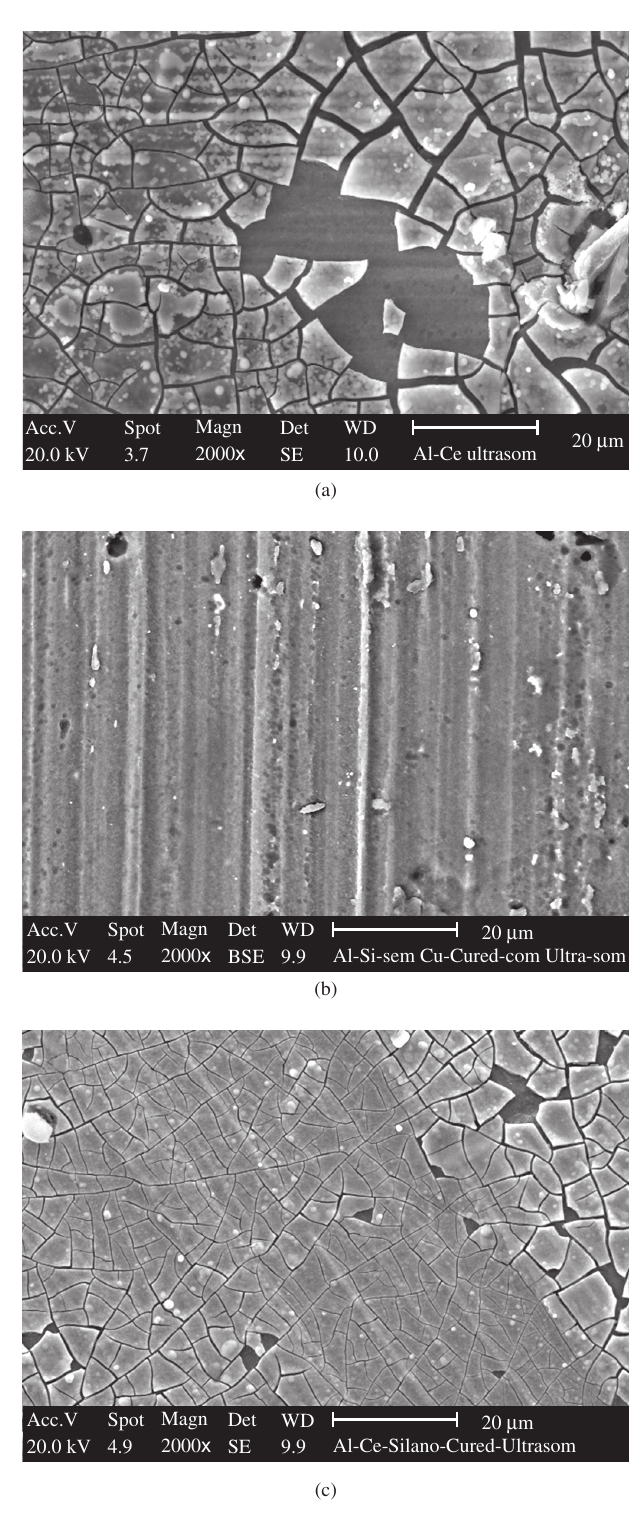
Figure 2. SEM micrographs of the AA 2024-T3 alloy after the ultrasonic bath. a) Cerium coated; b) Silane coated; and c) Cerium-silane coated (cured).